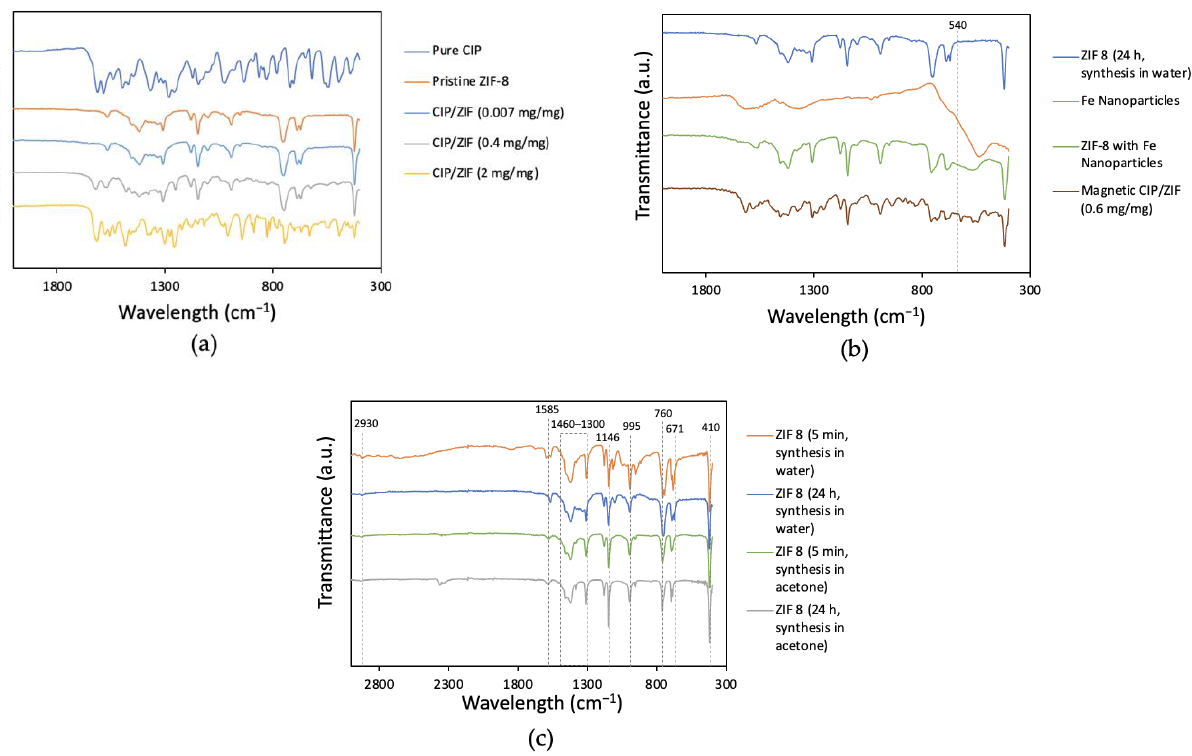
Figure 5. FT-IR spectra of ( a ) ZIF-8 and encapsulated CIP in ZIF-8 at different loadings; ( b ) magnetic CIP/ZIF material and Fe NP; and ( c ) ZIF-8 with different synthesis conditions.